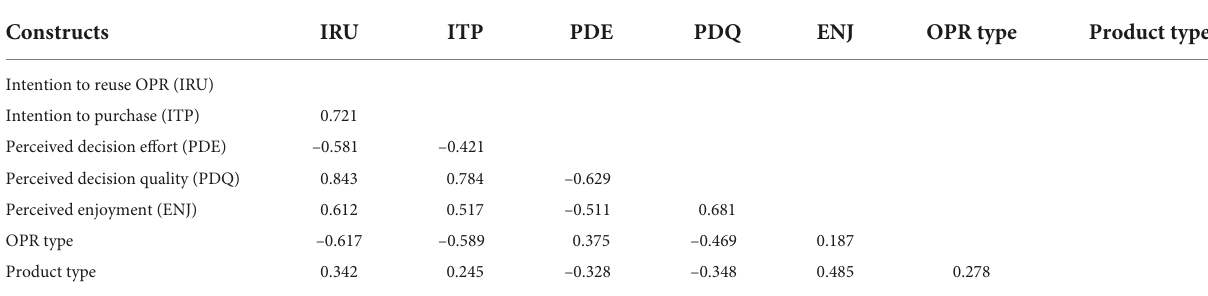
TABLE 8 HTMT results of discriminant validity.